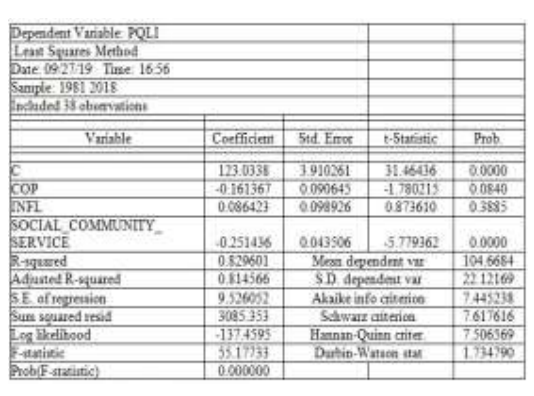
Table 6: Model 2 (Least Square Method of Analysis)